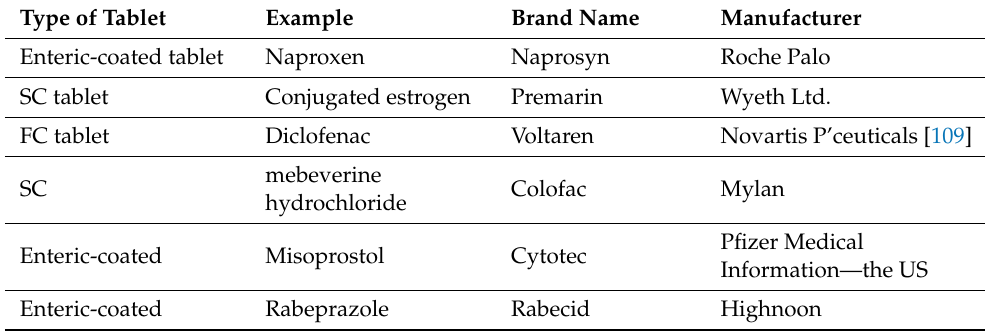
Table 8. Some of the marketed products were